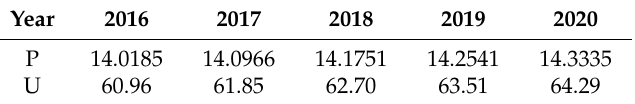
Table 5. Predicted results of populations (10 8 person) and urbanization (%) for